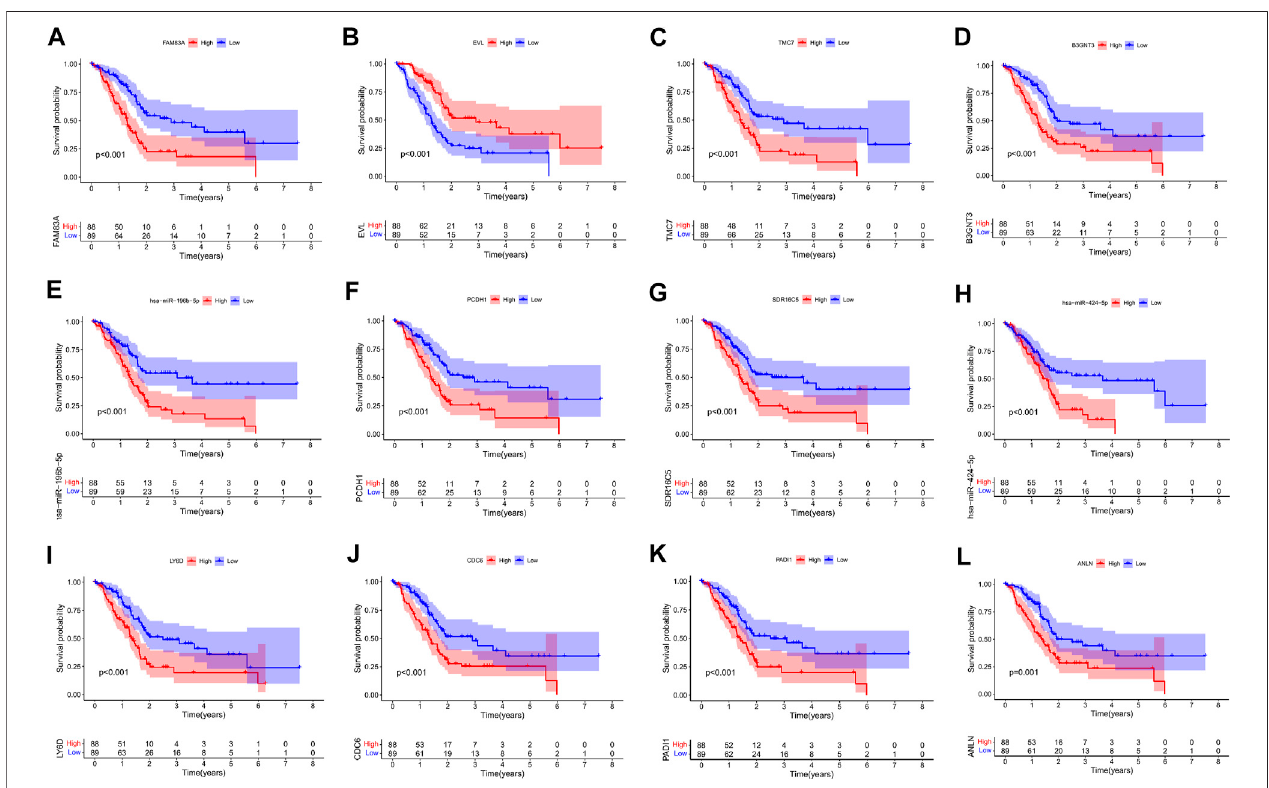
FIGURE 4 | Kaplan – Meier survival curves of the former 12 genes in the ceRNA networks: FAM83A (A) , EVL (B) , TMC7 (C) , B3GNT3 (D) , hsa-miR-196b-5p (E) , PCDH1 (F) , SDR16C5 (G) , hsa-miR-424-5p (H) , LY6D (I) , CDC6 (J) , PADI1 (K) , and ANLN (L) .